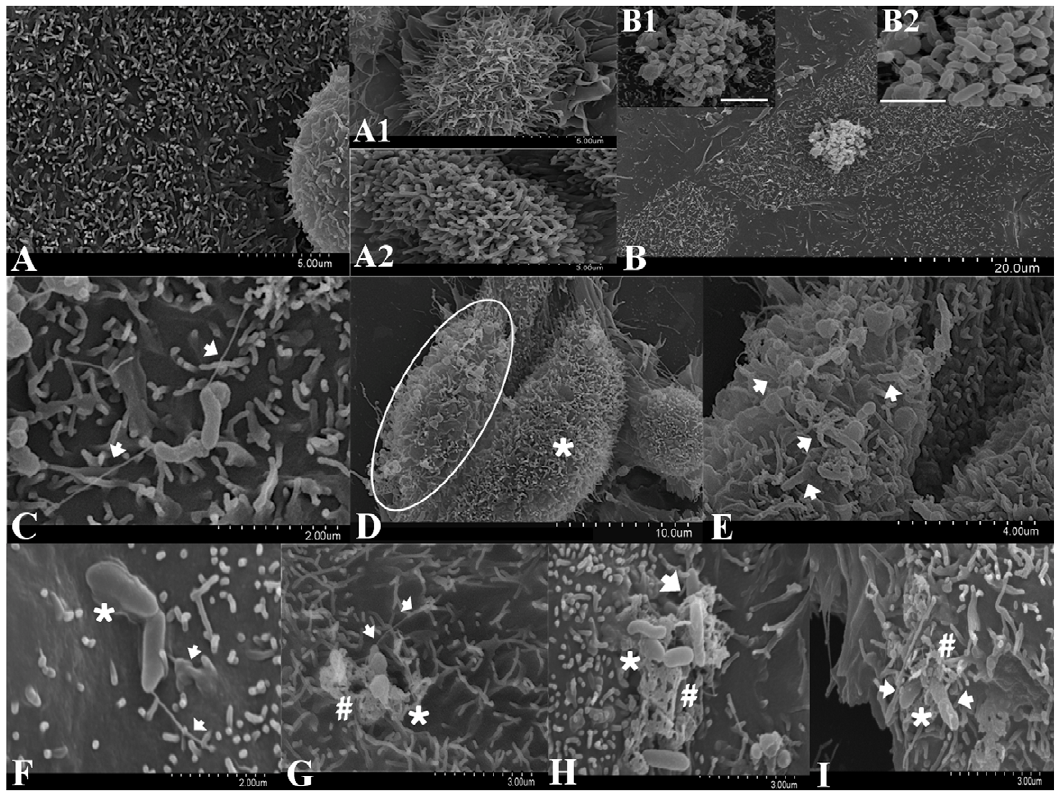
Figure 2. Scanning electron microscopy of human intestinal cell line Caco-2 infected with Campylobacterconcisus strains for six hours. Panel A shows an overview of uninfected Caco-2 monolayer. The Caco-2 cells expressed differentiating microvilli (Panel A1) and differentiated microvilli (Panel A2). C. concisus was shown to aggregate upon interaction with host cells as shown in Panel B (Panel B1, bar=1.5 m m and Panel B2, bar=2 m m). In Panel C, the polar flagellum of C. concisus is shown binding to the tips of host cell microvilli which mediated initial contact with host cells (as indicated by the arrows). Abnormalities in the epithelial host cell structure and microvilli were observed following infection with C. concisus (indicated by a ring in Panel D and arrows in Panel E). Panel F shows the flagellum of C. concisus appeared to wrap itself around the microvilli (as indicated by arrows). Following adherence, C. concisus induced a ‘‘membrane ruffling’’-like effect on the host cell membrane (indicated by an asterisk in Panel F), and penetrated the host cell membrane from the non-flagellated end (indicated by an arrow in Panel G). C. concisus was observed invading the host cell (indicated by arrows in Panels G, H and I) resulting in irregular shaped membrane protrusions (indicated by asterisks in Panels G, H and I), leading to host cell damage (indicated by ‘‘ # ’’ in Panels G, H and I).